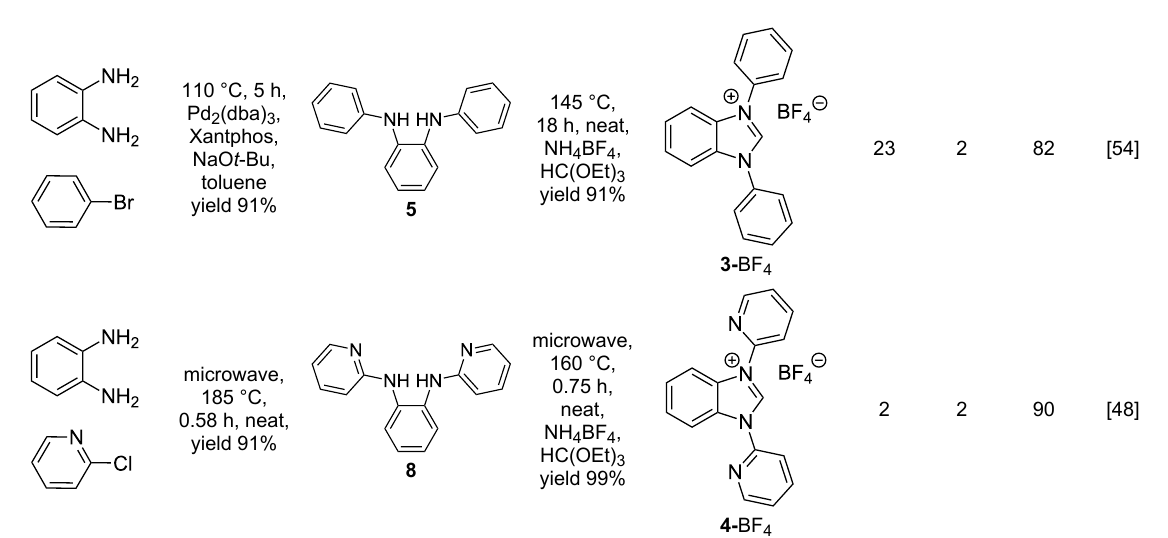
Table 1: Comparison of various preparations of the benzannulated NHCs: 1 -Cl, 2 -Cl, 3 -Cl and 4 -Cl, and of 1 -BF 4 , 3 -BF 4 and 4 -BF 4 . (continued)